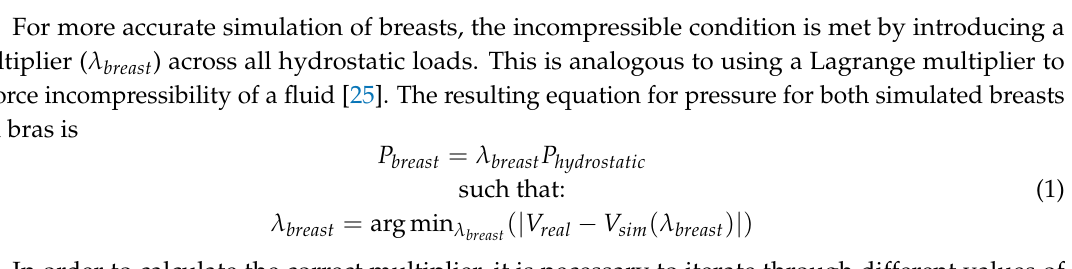
Figure 6. Side view diagram of applying a multiplier ( λ ) to FDM breast.